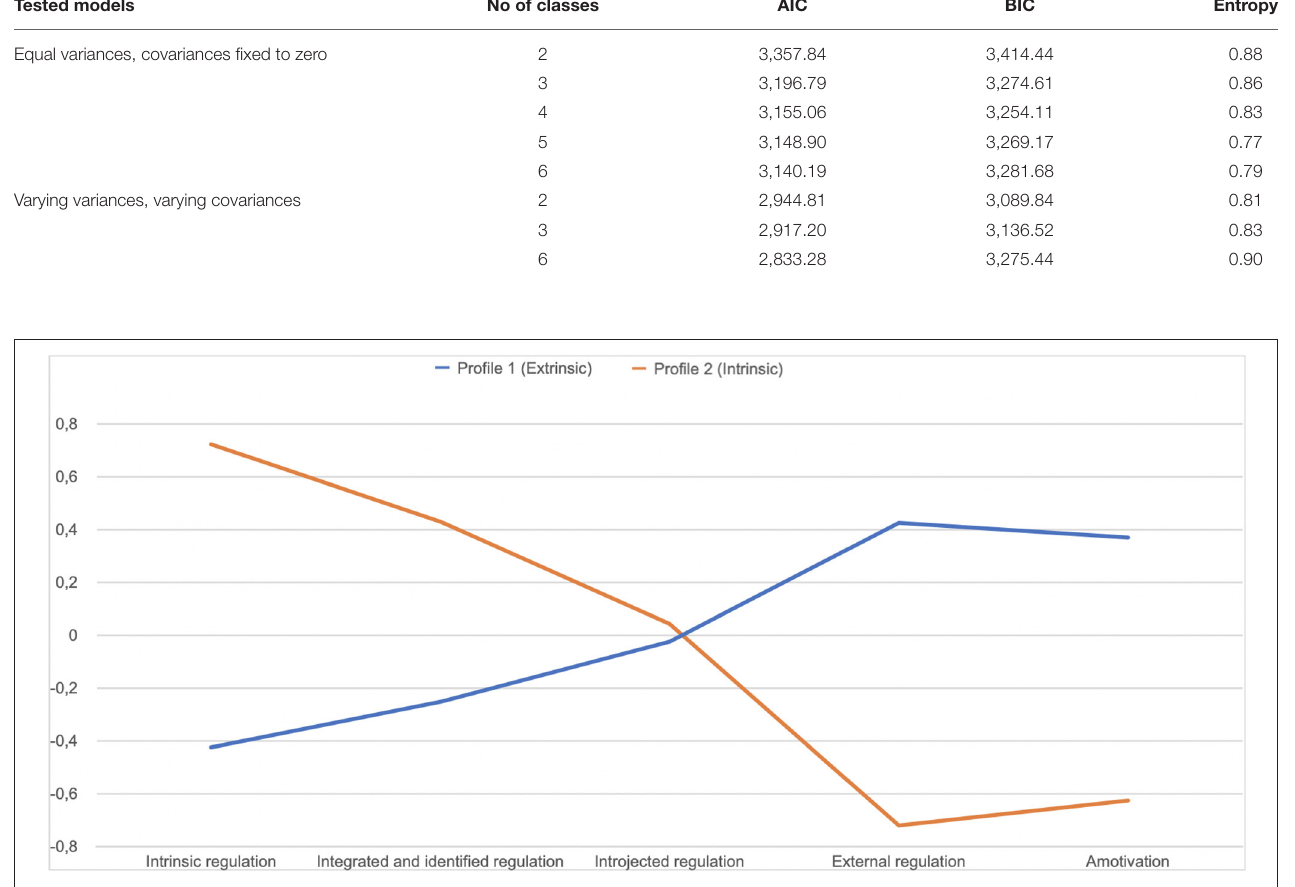
FIGURE 4 | Profiles of regulatory styles (Study 2).